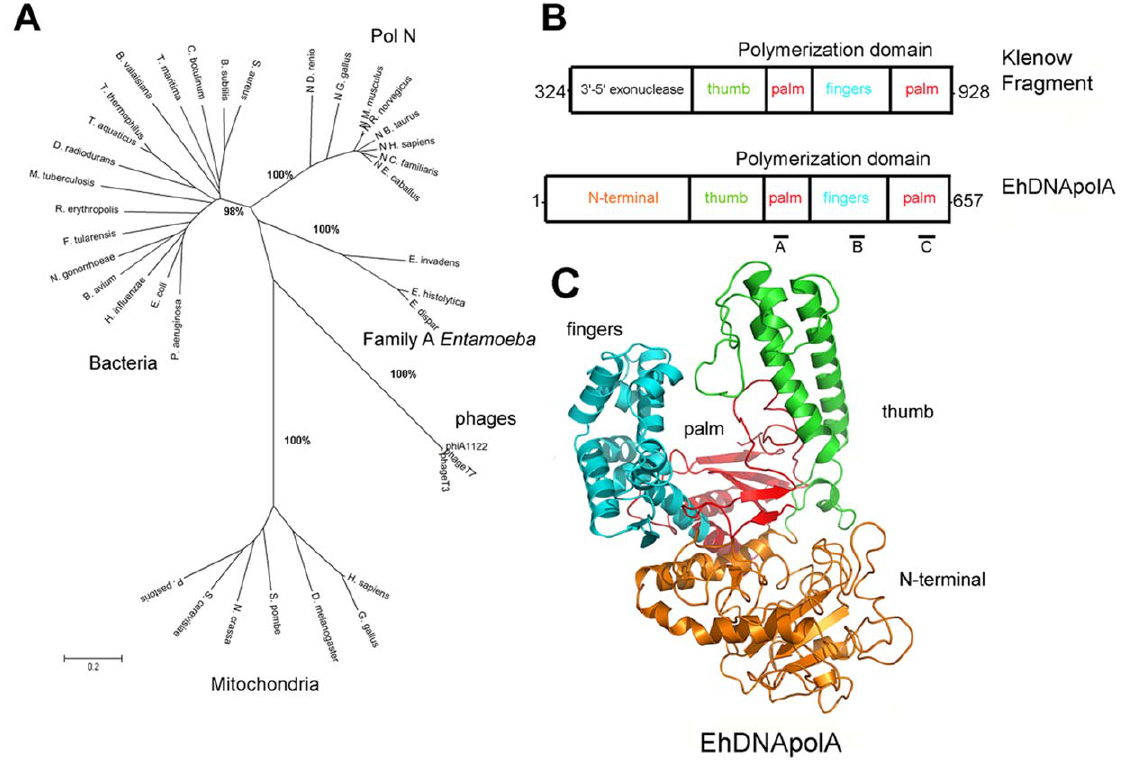
Figure 1. Phylogenetic analysis and structural modeling of E.histolytica family A DNA Polymerase. ( A ) Phylogenetic relationship of family A polymerases from different organisms. ClustalW multiple sequence alignment of diverse DNA polymerases were used to construct a phylogenetic tree using the neighbor joining algorithm present in the MEGA program. GenBank accession numbers of each protein are indicated in Table S2. The significance of each branch of the phylogenetic tree is indicated by a bootstrap percentage ( B ) Domain organization of EhDNApolA. EhDNApolA lacks the 3 9 -5 9 exonuclease domain present in Klenow fragment. The polymerization domain of EhDNApolA is organized into three subdomains: thumb, palm, and fingers ( C ) Structural model of EhDNApolA. The N-terminal domain is shown in orange. The polymerization subdomains: thumb, palm, and fingers are colored in green, red, and cyan respectively. The model was constructed using the crystal structure of Klenow Fragment as a template (PDB ID: 1KFS).